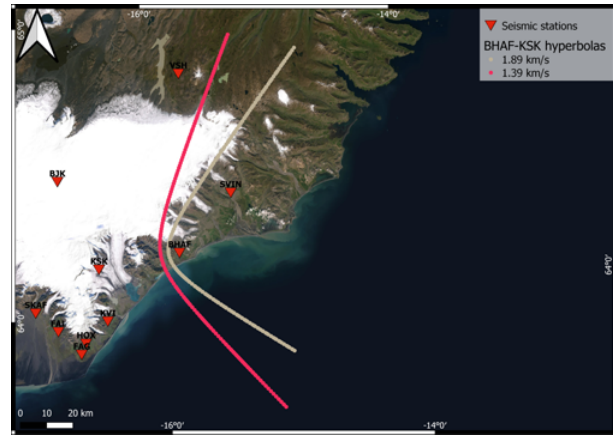
Figure 5: Map of hyperbolas for a lag time of 12.2 s and an interstation distance of 31.3 km, showing the dif- ferences between two propagation velocities, 1.39 and 1.89 km s −1